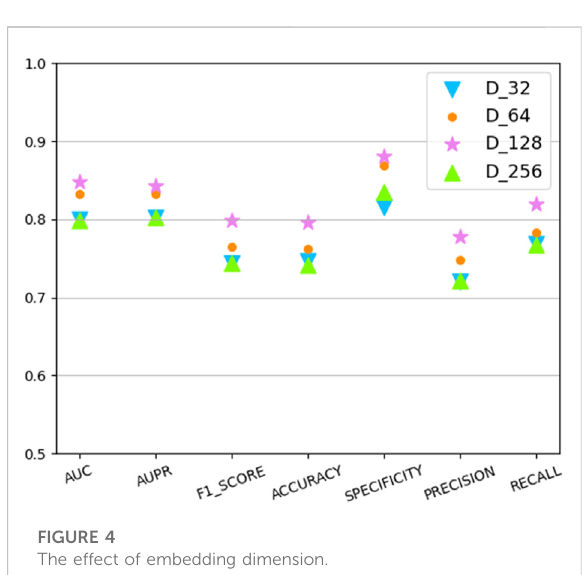
FIGURE 4 The effect of embedding